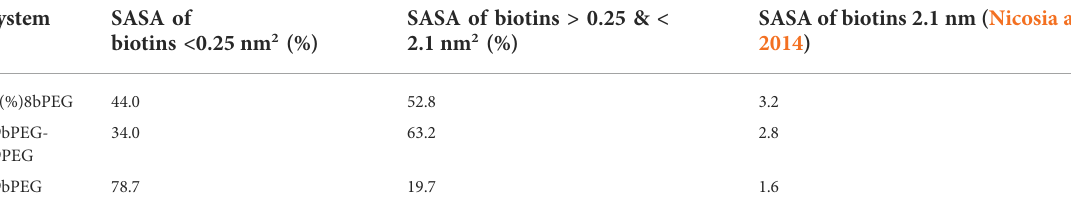
TABLE 2 Three different regimes of SASA of biotins generated for different surfaces over trajectories. System